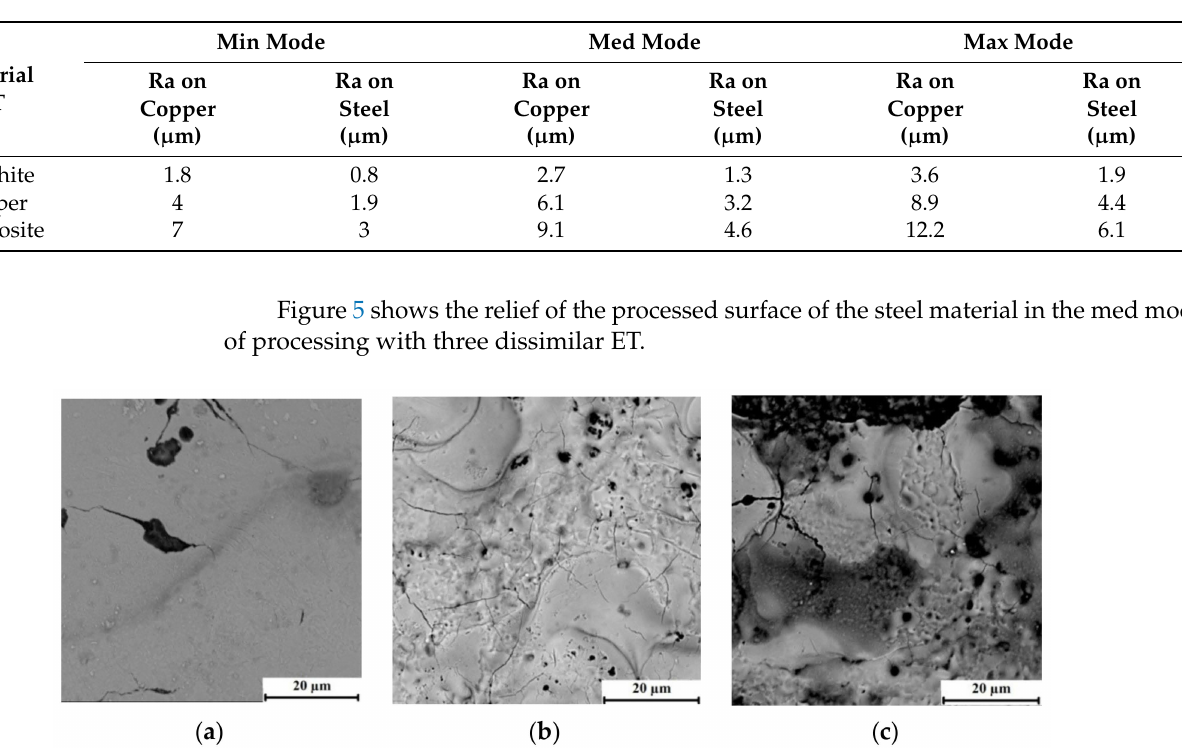
Table 6. Roughness parameter of bimetallic material when processing heterogeneous ET in three modes.